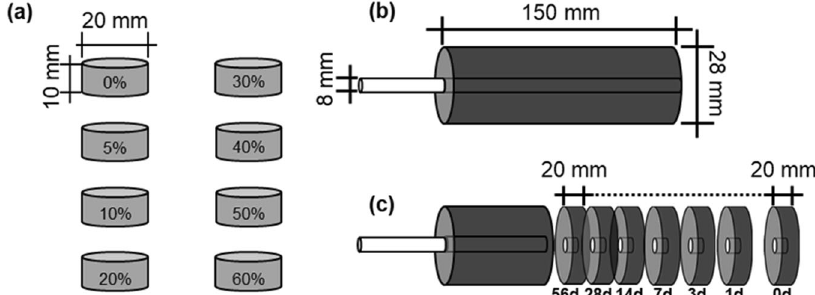
Fig. 8 Schematic diagram for the sample preparation. a Standard cement specimens. b Cement paste specimens. c Slices of the cement paste